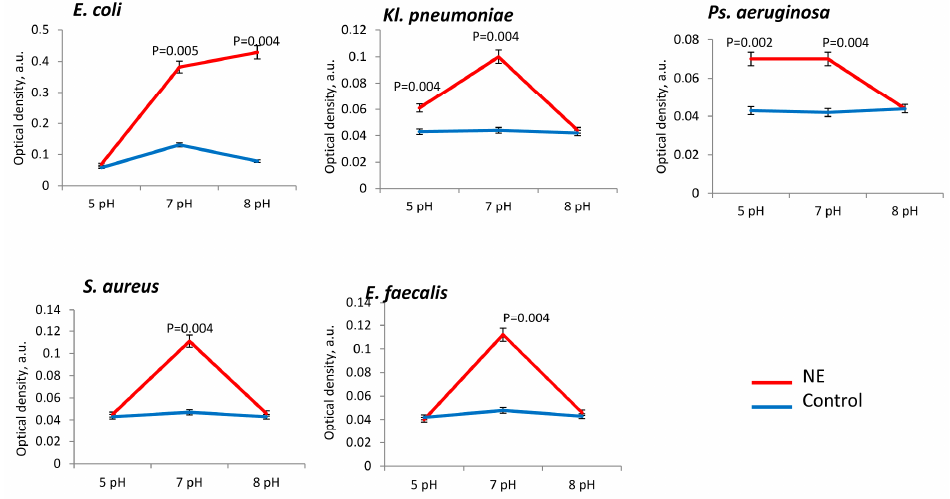
Figure 5. Bacterial metabolic activity is influenced by pH and the presence of NE in PBS.